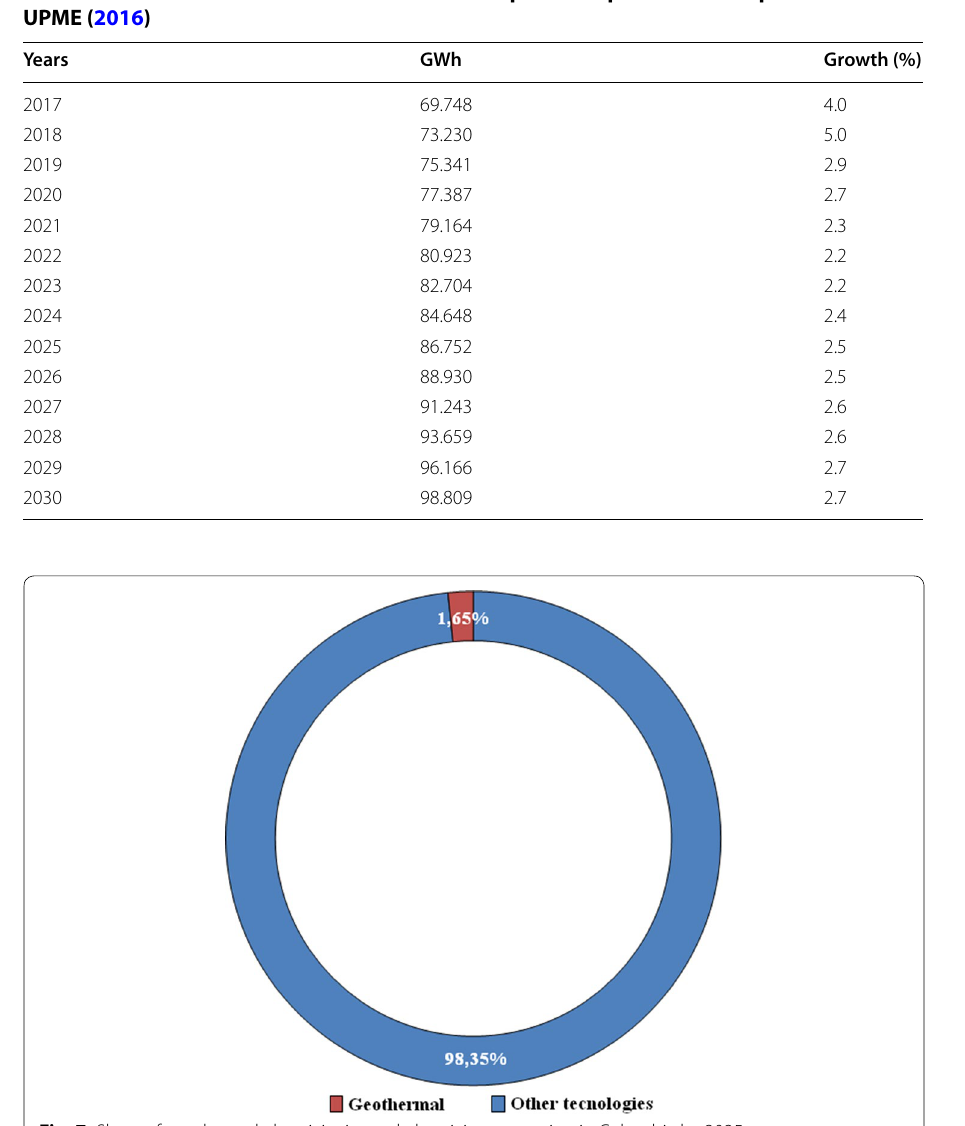
Table 3 Forecast of national demand for electric power. Reproduced with permission from